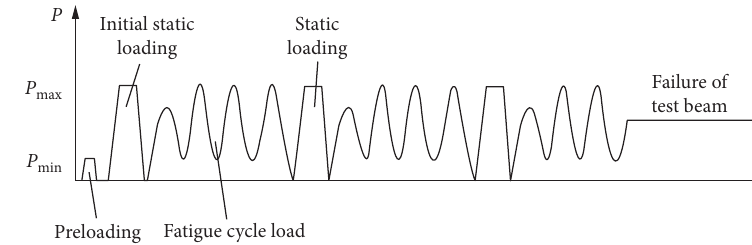
Figure 6: Fatigue loading program.